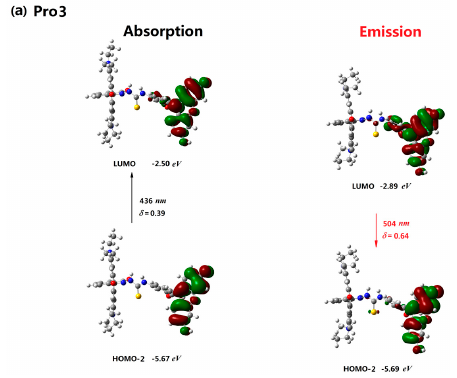
2 O. Figure 4. The absorption and emission of ( a ) Pro2 and ( b ) Pro2+Hg 2+ in H 2 O.